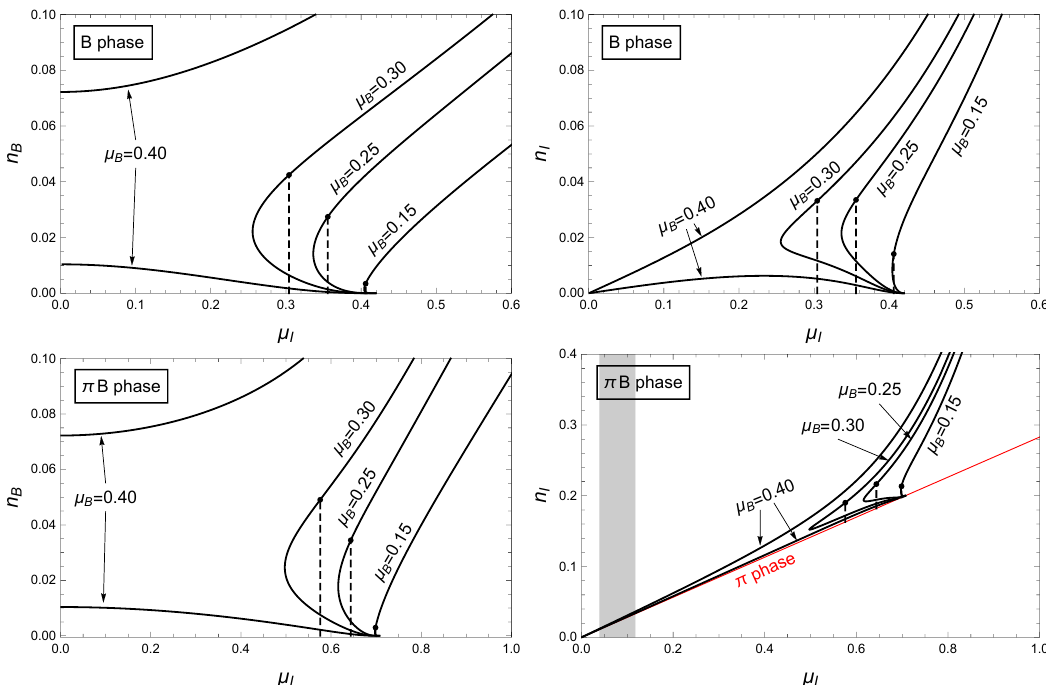
Figure 3: Counterpart to Fig. 2, now with fixed values of µ instead of µ . Top row: Dimen- B I sionless baryon and isospin number densities n and n in the pure baryon phase as functions B I = 0.40 there are two dis- of µ at fixed values for the baryon chemical potential µ . For µ I B B connected branches, the lower one being unstable. Bottom row: Same quantities in the coexistence phase. The thin (red) line shows the behavior of n in the pure pion-condensed I phase, which is linear in µ and identical to the result from chiral perturbation theory, see Eq. I (52). The gray band in the lower right panel indicates the physical pion mass m π (cid:39) 140MeV = ( 500 − 1500 ) MeV, i.e., even if the pion mass was taken into account in for the range M KK the calculation, pion condensation is expected to occur everywhere to the right of that